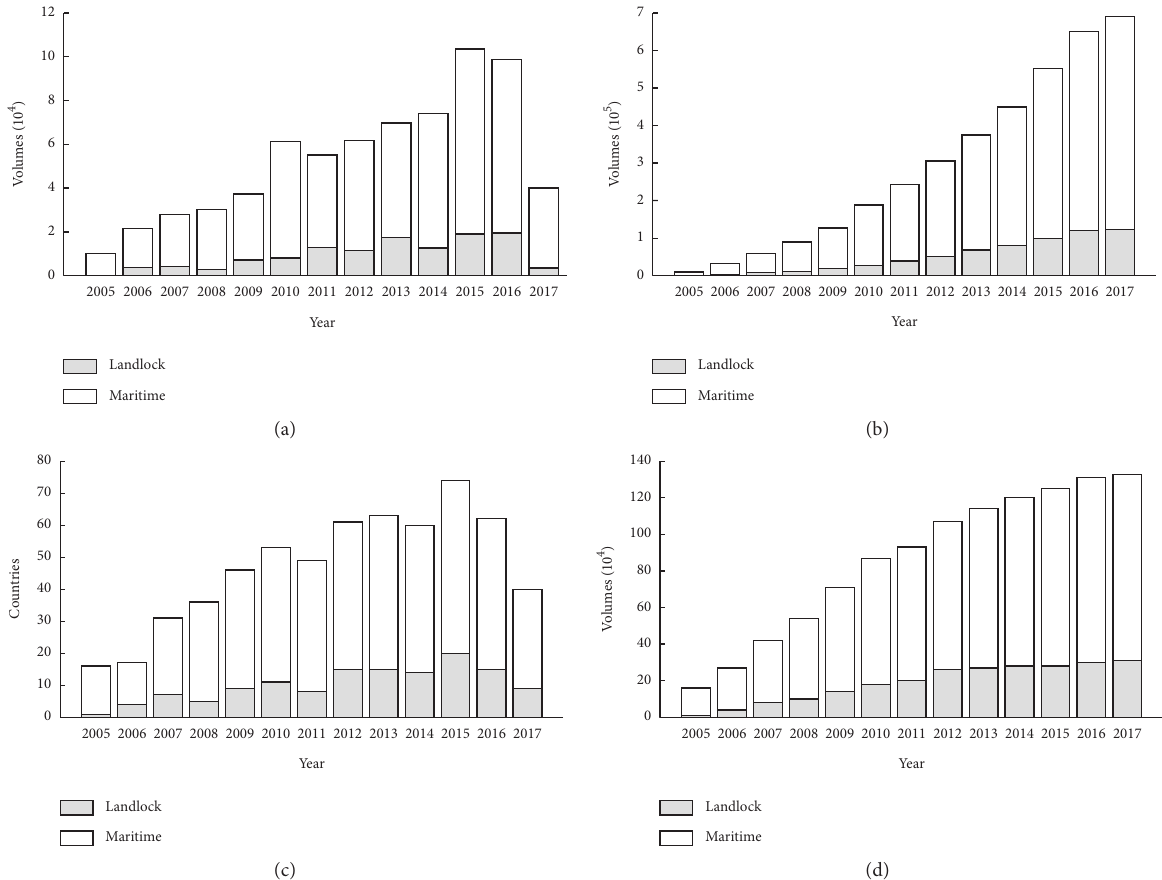
Figure 15: Accumulated maritime and landlocked IEs (2005–2017) (No. 5): (a) annual millions; (b) annual accumulated millions; (c) annual involved countries; (d) annual accumulated involved countries.